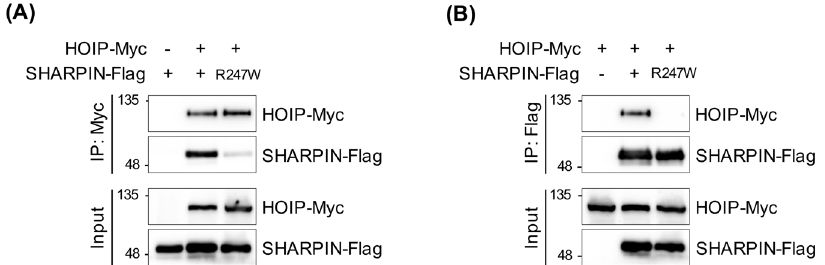
Fig. 4 Effect of mutant SHARPIN (R274W) on binding with HOIP. 293T cells transiently co-transfected with Flag-tagged WT and mutant SHARPIN and Myc-tagged HOIP were immunoprecipitated using anti-Myc antibody ( A ) and anti-Flag antibody ( B ). The binding af fi nity between SHARPIN variants and HOIP was con fi rmed through western blot analysis using anti-Myc and anti-Flag antibody,